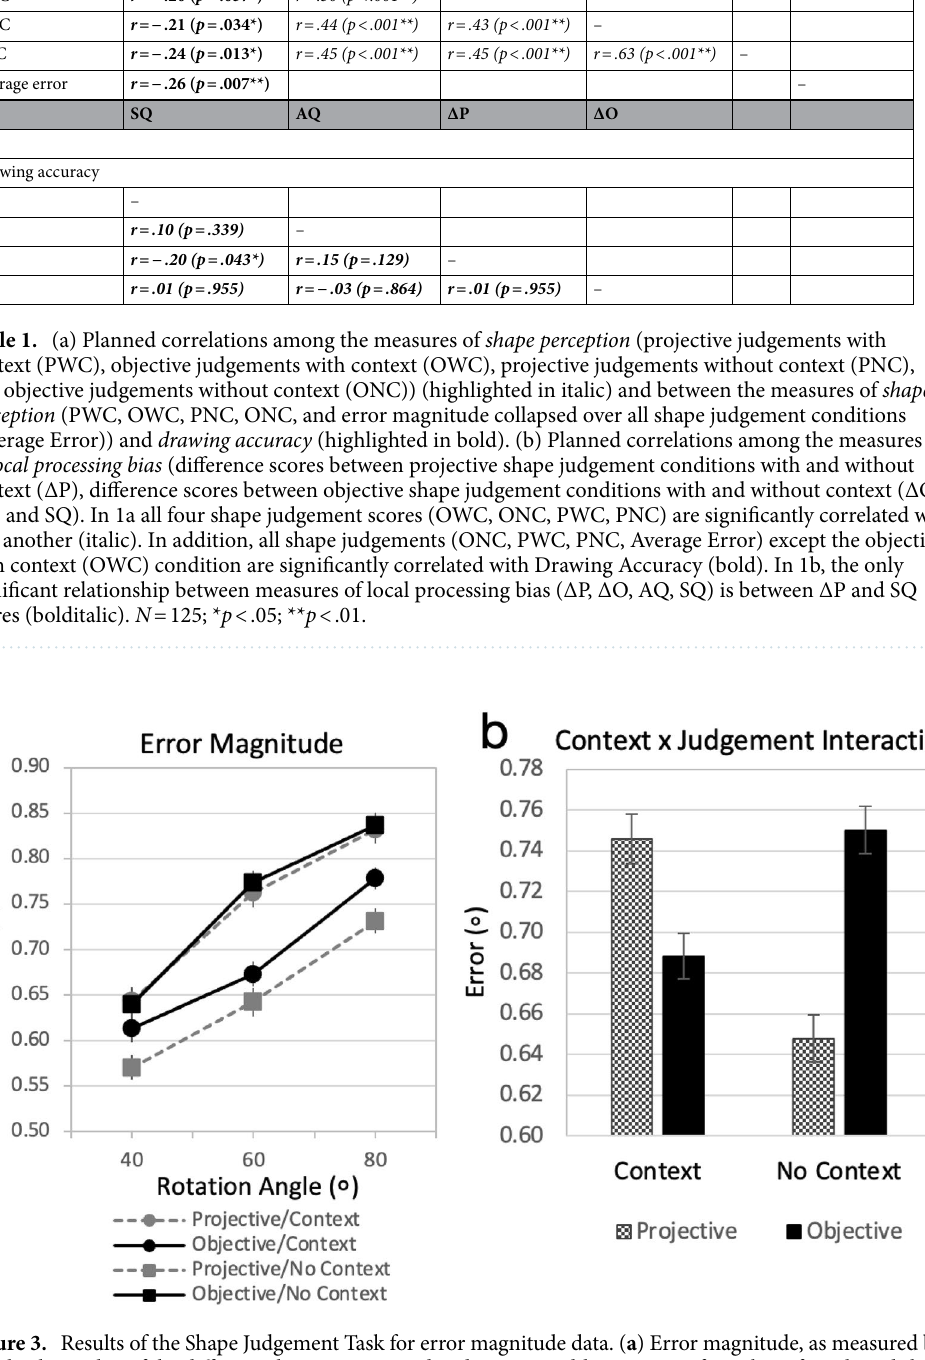
Figure 3. Results of the Shape Judgement Task for error magnitude data. ( a ) Error magnitude, as measured by the absolute value of the difference between reported and correct widths in terms of number of pixels and shown in degrees of visual angle, is plotted as a function of stimulus rotation angle (40°, 60°, 80°), context (context, no context), and judgement type (projective, objective). ( b ) Error magnitude is plotted (in terms of degrees of visual angle) as a function of context (context, no context) and judgement type (projective, objective). Error bars represent ± 1 SEM